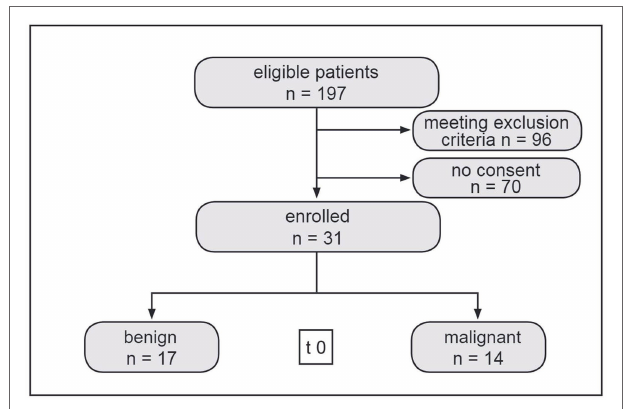
FIGURE 1 | Flow chart depicting patient